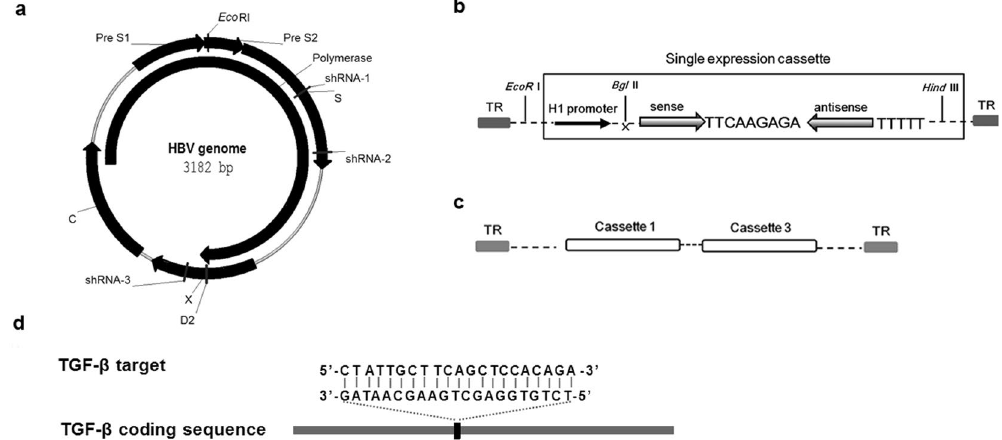
Figure 1. Design of shRNAs targeting HBV and TGF- β specific sites and schematic diagram of the AAV expression cassette. ( a ) Schematic of the HBV genome and the locations of the shRNA targets. ( b ) Schematic of an AAV vector containing a single shRNA expression cassette. ( c ) Schematic of AAV vectors containing dual shRNA expression cassettes. ( d ) Schematic representation of the location of the shRNA target within the TGF- β coding sequence. TR, terminal